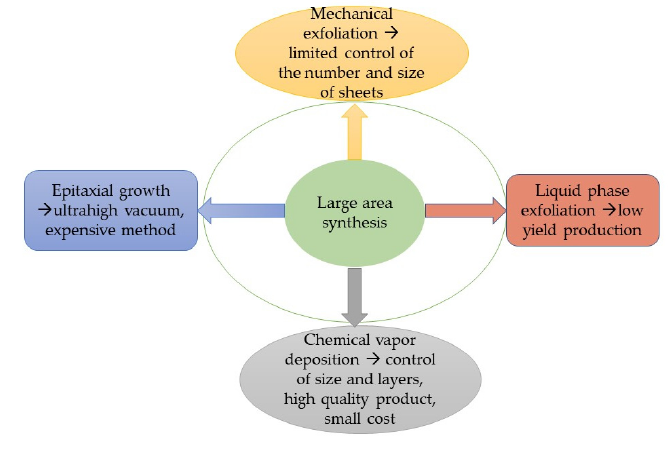
Figure 2. Large area synthesis methods.